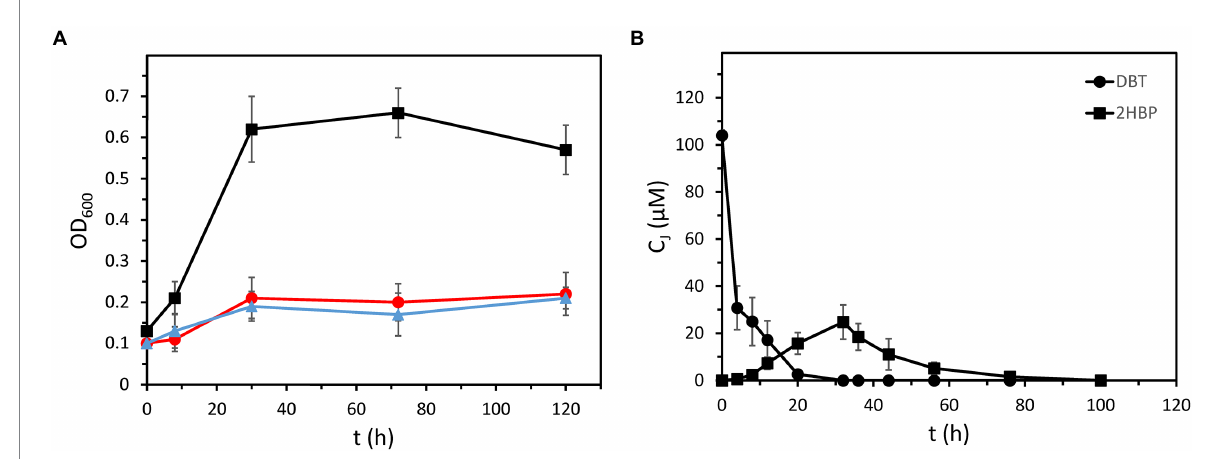
FIGURE 2 Growth of recombinant P. azelaica AJdsz using DBT as the only sulfur source. (A) Growth of recombinant P. azelaica AJdsz in BSM containing 100 μ M of DBT as the only sulfur source, 0.2% (w/v) glucose as carbon source, and 1 mM IPTG to induce the dsz gene expression (black squares). Control experiments of P. azelaica AJdsz without DBT (blue triangles) and wild-type P. azelaica AJ strain with DBT (red circles) are shown. (B) Time course of the evolution of DBT (black circles) and 2HBP (black squares) during growth of recombinant P. azelaica AJdsz in DBT as only sulfur source. C j indicates the concentration of the monitored compound. Values are the mean of three different experiments. Error bars indicate standard deviations.